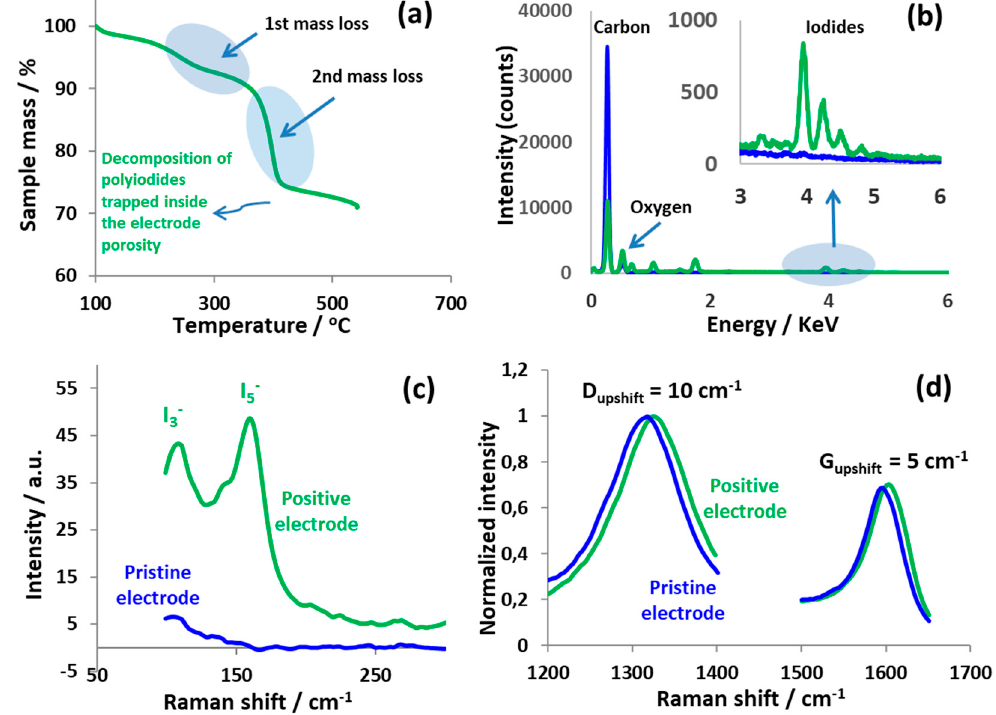
Figure 4. Various analyses on positively polarized ACC electrode (green line) in a hybrid cell using 1 mol L − 1 NaI up to 1.5 V. ( a ) Thermogravimetric analysis at heating rate of 10 ◦ C / min; ( b ) energy dispersive X-ray analysis compared with pristine material (blue line); ( c ) raman spectra at low wavenumber; and ( d ) D- and G-band region.